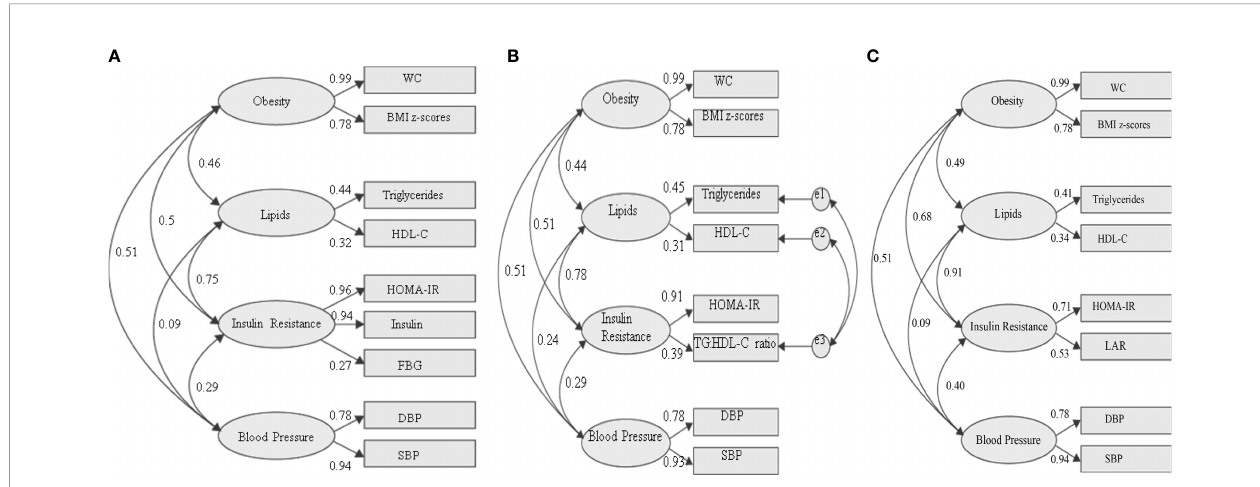
FIGURE 3 | Three different models of metabolic syndrome structures with changed variables in the IR group. (A) Fasting blood glucose as measures of IR [ fi tness indices: P value (<0.05) = <0.001; RMSEA (<0.10) = 0.095; CFI (>0.9) = 0.957; TLI (>0.9) = 0.926]. (B) TG: HDL-C ratio as a measure of IR [ fi tness indices: P value (<0.05) = <0.001; RMSEA (<0.10) = 0.071; CFI (>0.9) = 0.987; TLI (>0.9) = 0.969]. (C) LAR as a measure of IR fi tness indices: P value (<0.05) = <0.001; RMSEA (<0.10) = 0.064; CFI (>0.9) = 0.978; TLI (>0.9) = 0.955. The standardized factor loadings shown for all models are all statistically signi fi cant (P < 0.001). WC, waist circumference; FBG, fasting blood glucose; DBP, diastolic blood pressure; SBP, systolic blood pressure; LAR, leptin:adiponectin ratio; e, residual